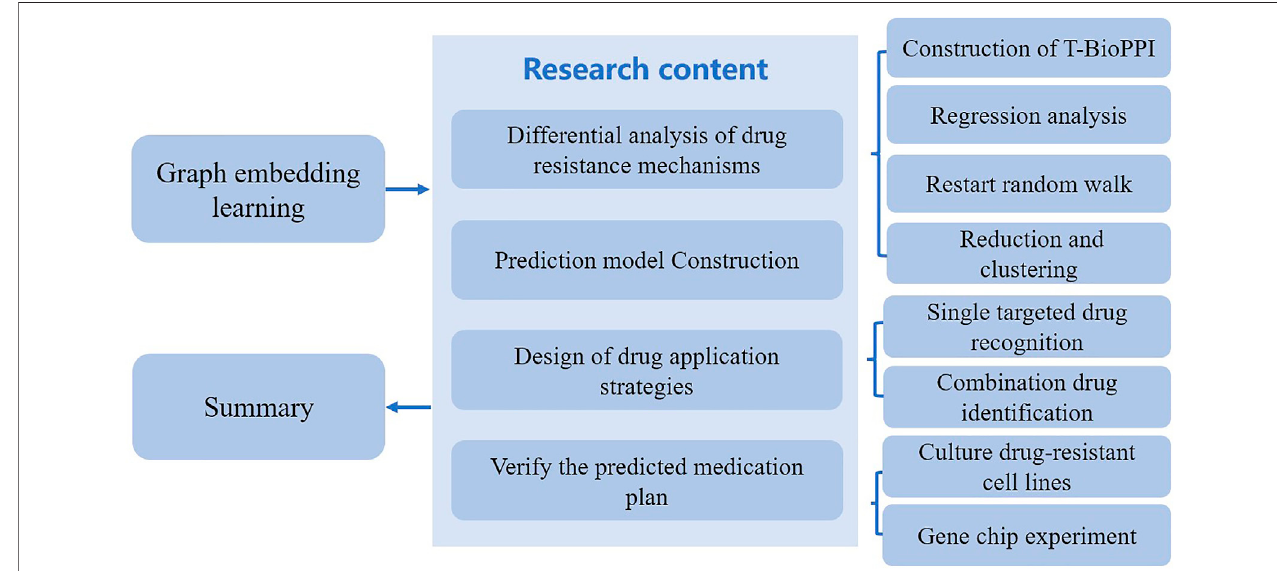
FIGURE 2 | Diagram of the research content on the evolution model of drug resistance.